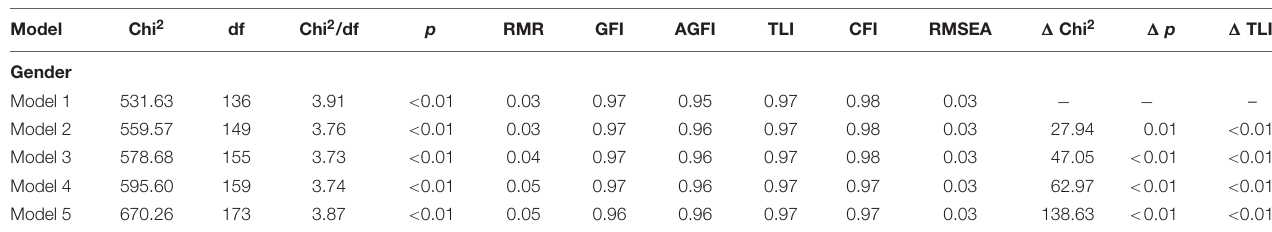
TABLE 6 | Nested Models of Multigroup SEM across male and